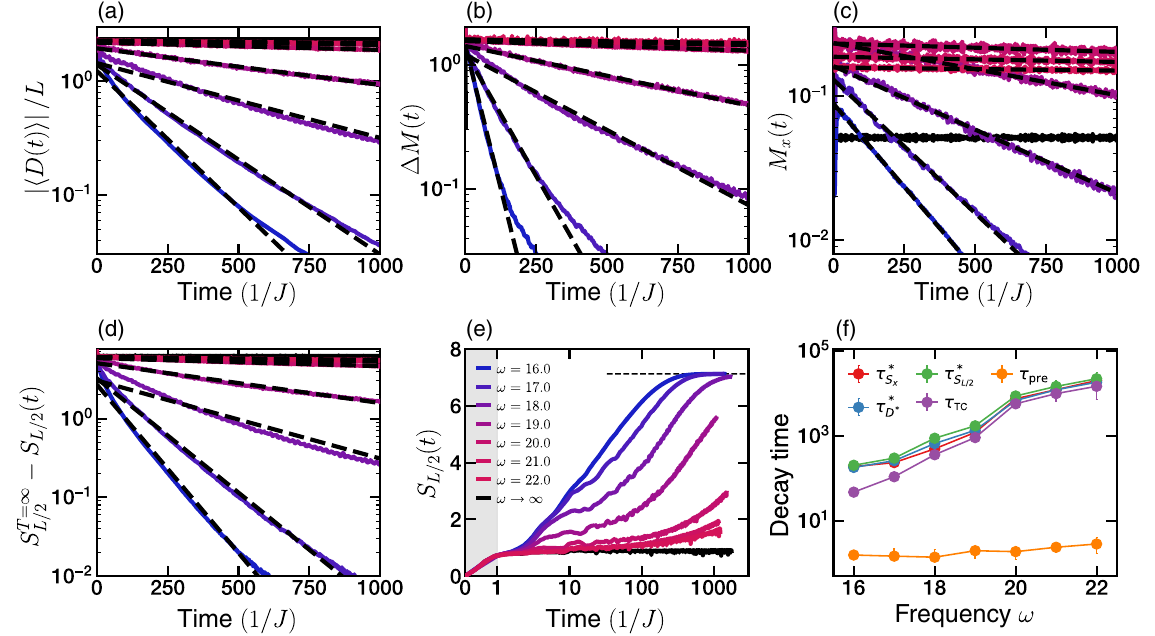
FIG. 7. Example of the fitting procedure for extracting the decay times for a particular initial state evolved with the long-range Floquet evolution. We apply the same procedure to all initial states in both the short- and the long-range model. We observe that a simple exponential decay captures the approach of different observables to their thermal values: (a) energy density h D ð t Þi =L , (b) time crystalline order parameter Δ M ð t Þ , (c) ˆ x magnetization M x ð t Þ (here plotted with a moving average over five points for clarity), and (d) half-chain entanglement entropy S L= 2 ð t Þ . (e) The entanglement entropy provides an extra timescale τ which captures the approach pre to the prethermal state. The x axis in the shaded region is linear with time to emphasize the early time entanglement entropy behavior. (f) Comparison of the different decay times. The decay time of the energy density τ (cid:2) D , entropy τ (cid:2) S , and ˆ x magnetization τ (cid:2) S provide (cid:2) L= 2 x different estimates of the true thermalization timescale of the system τ (cid:2) . Because this particular initial state is a “ cold ” state of the long- range model, it hosts a prethermal time crystal; the decay of the time crystalline order parameter also occurs at τ (cid:2) . The agreement of all these timescales further corroborates the existence of a prethermal time crystal and the existence of a single thermalization timescale. Finally, we observe that τ occurs at a much earlier, frequency-independent pre